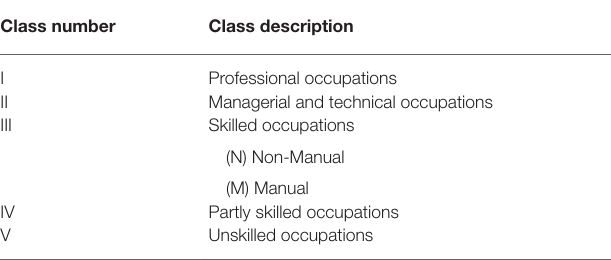
TABLE 1 | Parental socioeconomic status (SES) classes of the study sample, based on the Census 1951 Classification of Occupations of General Register Office